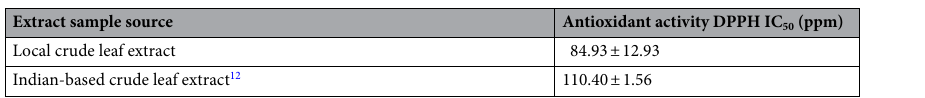
Table 8. Comparison between DPPH antioxidant IC 50 of local and Indian-based crude X. granatum leaves extract 12 .